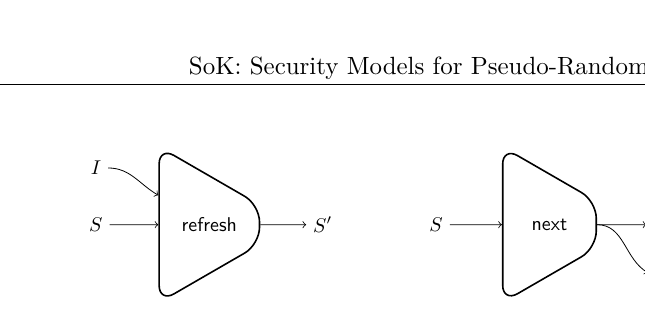
Figure 14: Pseudo-Random Number Generator with Input [BH05]